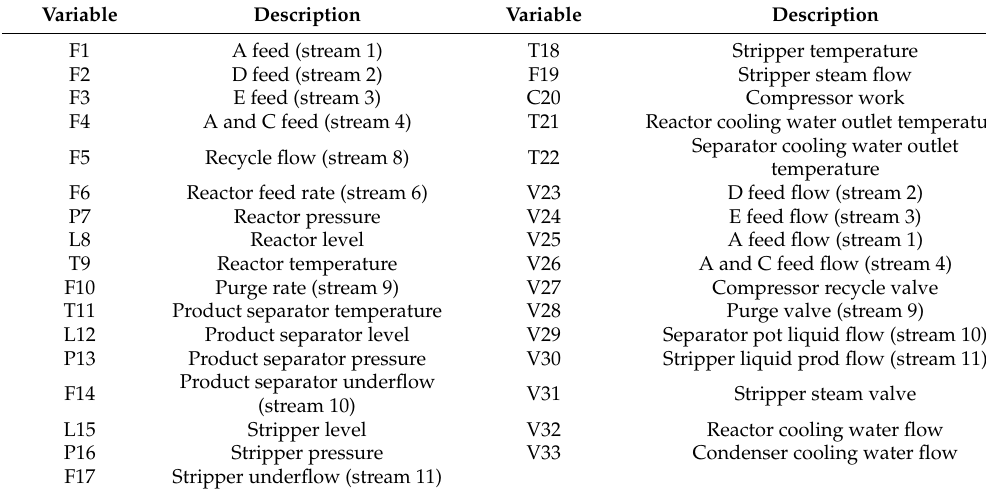
Table 2. Variable information of TEP for process